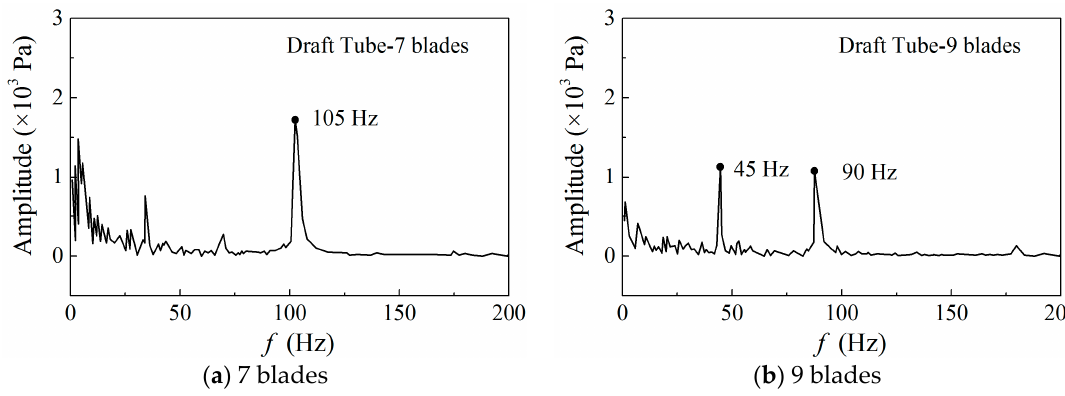
Figure 23. The main frequencies of pressure fluctuations at draft tube (7 blades and 9 blades).